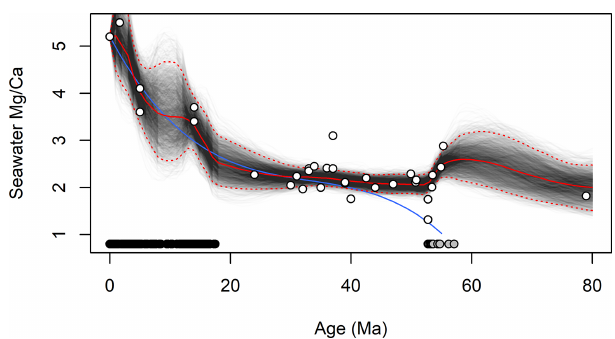
Figure 2. Reconstructed seawater Mg / Ca from 80Ma to present. Black lines show individual draws from the posterior distribu- tion for each time series; red lines show the median (solid) and 95% credible intervals (dotted). White-filled circles show individ- ual proxy estimates (Dickson, 2002; Coggon et al., 2010; Lowen- stein et al., 2001; Evans et al., 2018; Horita et al., 2002; de Vil- liers and Nelson, 1999), black and gray symbols at the bottom of the panel show the distribution of the foraminiferal Mg / Ca proxy data and Paleogene proxy calibration data, respectively, in time. The blue line is the curve-fit estimate of seawater Mg / Ca of Lear et al. (2015).